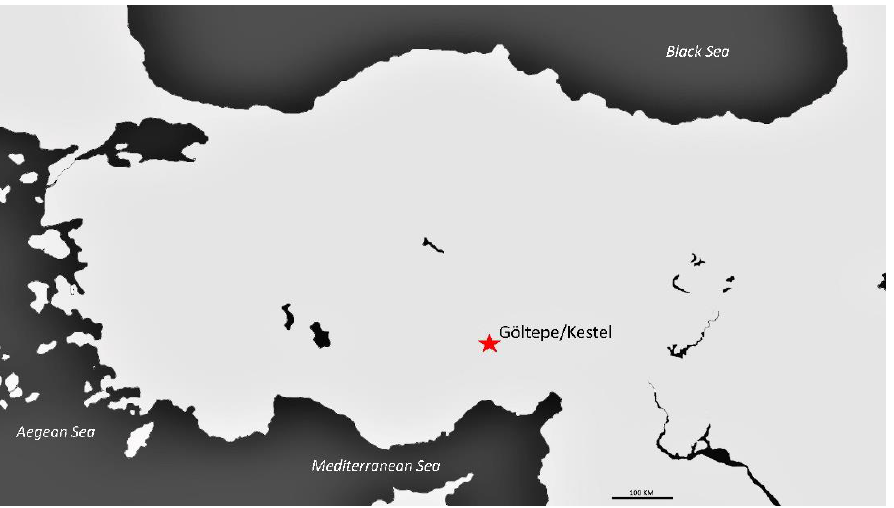
Figure 14. Map showing the geographic location of Göltepe and the Kestel mine site within modern day